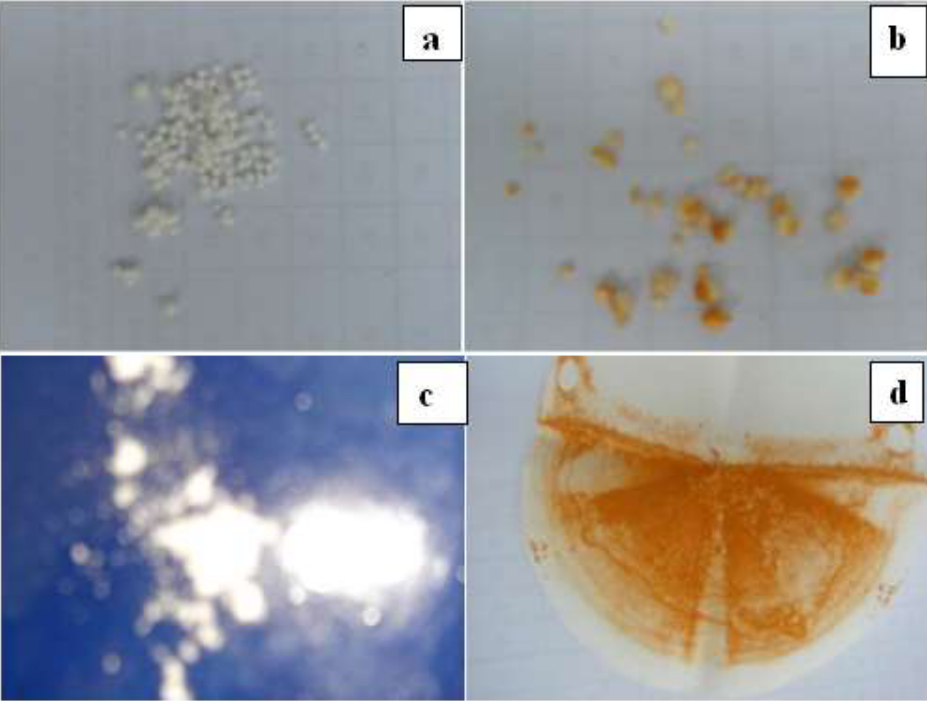
Figure 12. (I) Optical image of PES/[BMIM][PF 6 ] microsphere ( a ) before scale treatment and ( b ) after scale treatment. (II) Deposited calcium carbonate scale ( c ) before scale treatment and ( d ) after scale treatment [57].